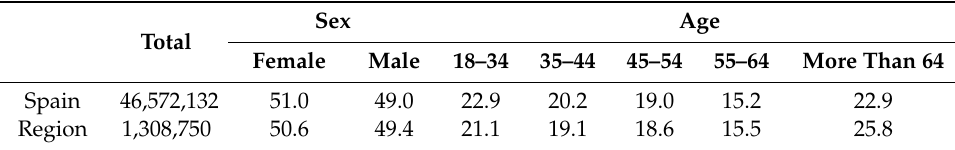
Table A1. Population by sex and age in Spain and in the region